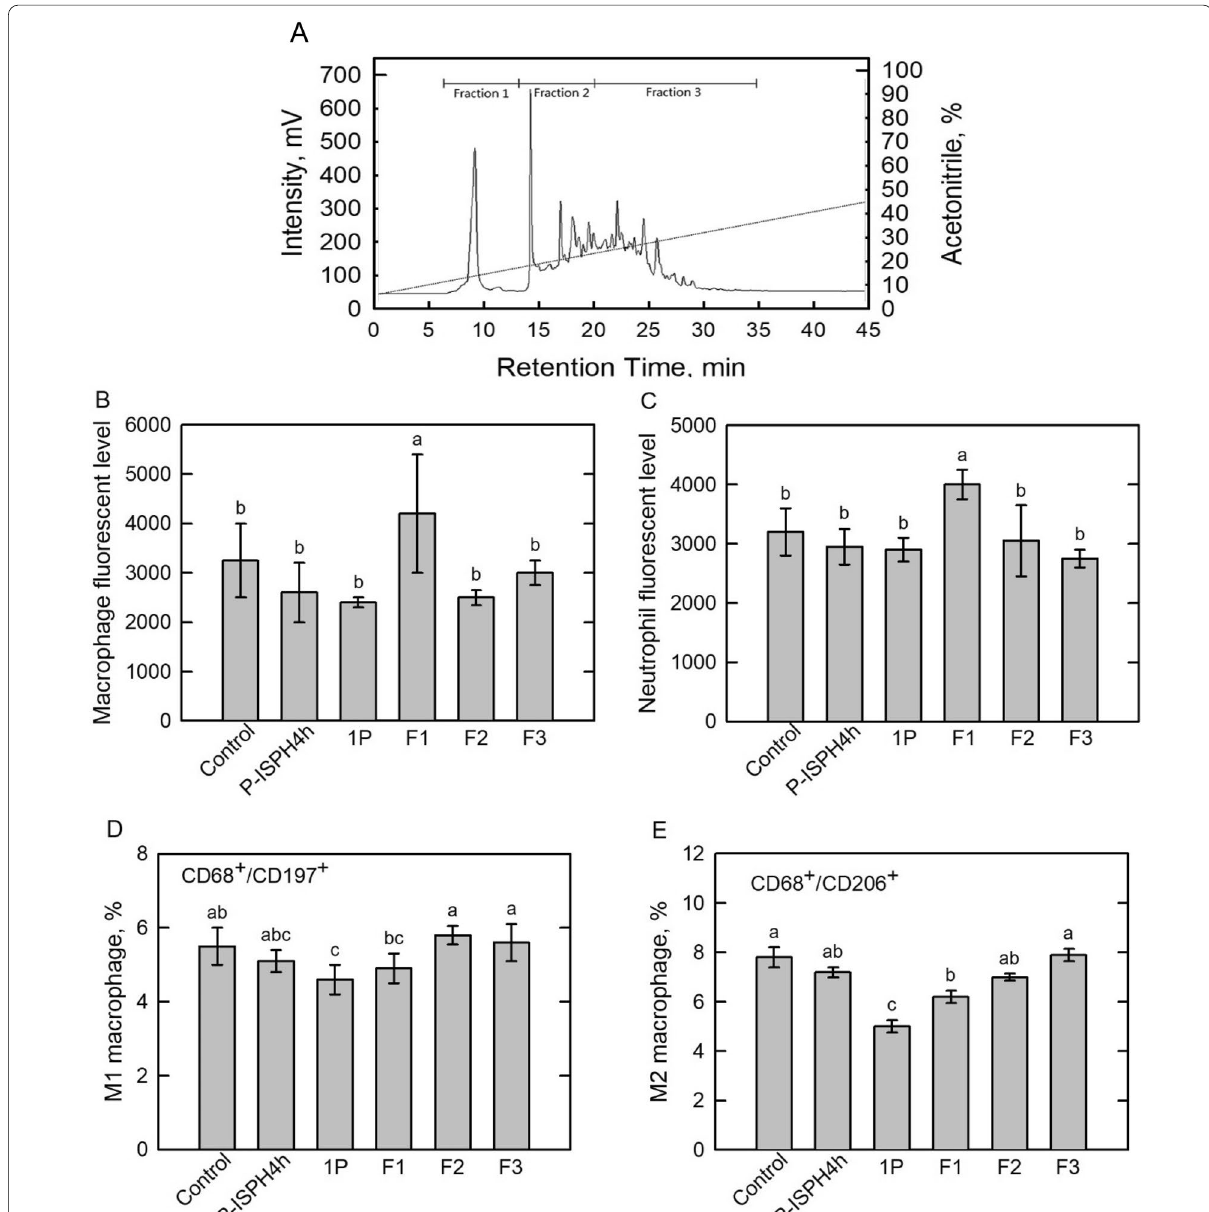
Fig. 5 Determation of anti‑inflammatory activity of Pepsin‑ISPH4h‑1P fractions. A Pepsin‑ISPH‑4 h‑1P was fractionated into F1–F3 using a reverse‑phase high‑performance liquid chromatography. Effects of Pepsin‑ISPH4h, Pepsin‑ISP4h‑1P, and F1–F3 fractions on positive fluorescent level in macrophages ( B ), neutrophil ( C ), M1 ( D ) or M2 ( E ) phenotype polarization in mouse spleen in vivo. Bars represent mean n 3). Mean with different letters are significantly different ( p < 0.05) by Duncan’s multiple range =